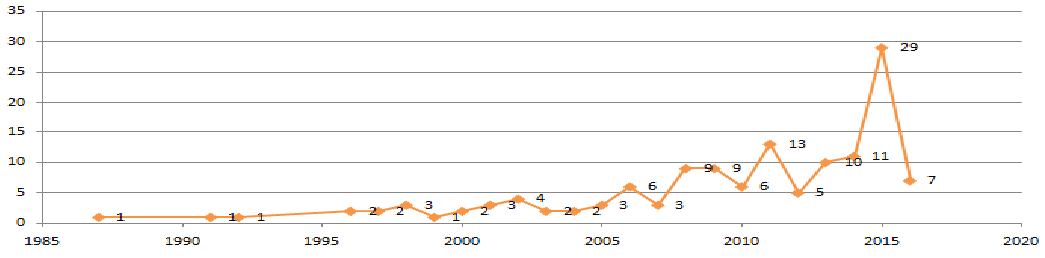
Diagram 1. Articles of present research work based on their publication year.